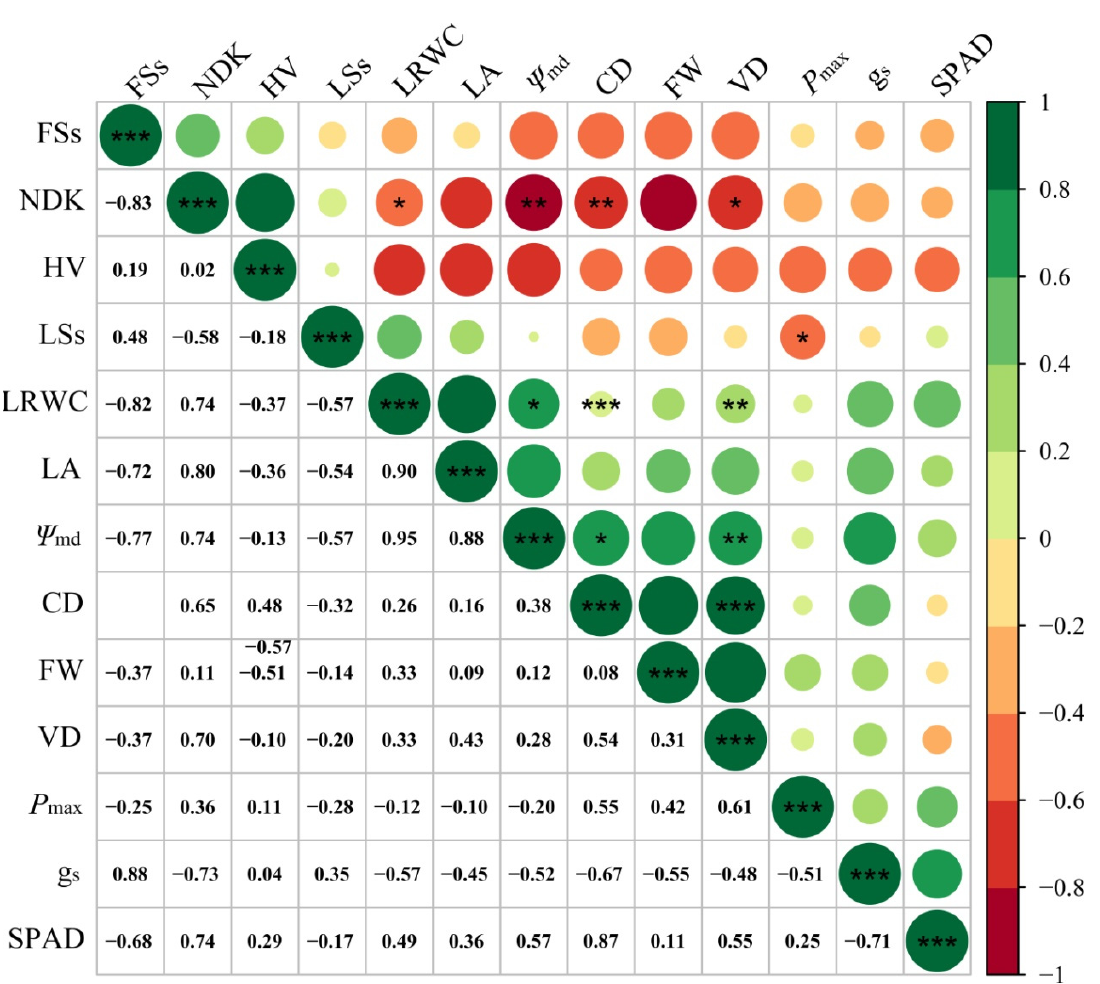
Figure 7. Correlation analyses between indicators at different irrigation levels. p < 0.05 denotes a significant correlation. p < 0.05 for *; p < 0.01 for **; p < 0.001 for ***. FSs: seed kernel soluble sugars; RED: empty deflated shell rate; HV: Huber value; lSs: leaf soluble sugars; RWC: relative leaf water content; LA: compound leaf area; Ψ md : midday leaf water potential; CD: fruit transverse diameter; FW: fruit weight; LD: fruit vertical diameter; Pmax: maximum net photosynthetic rate; g s : stomatal conductance; SPAD: chlorophyll SPAD